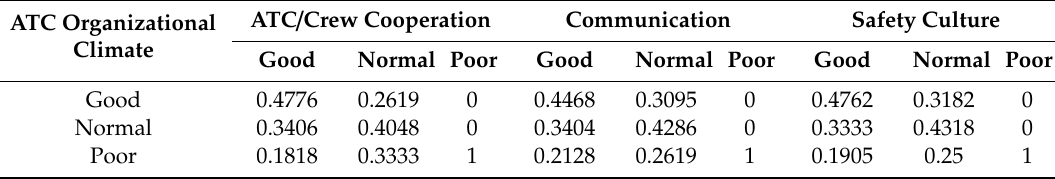
Table 3. Example of conditional probability table (CPT)